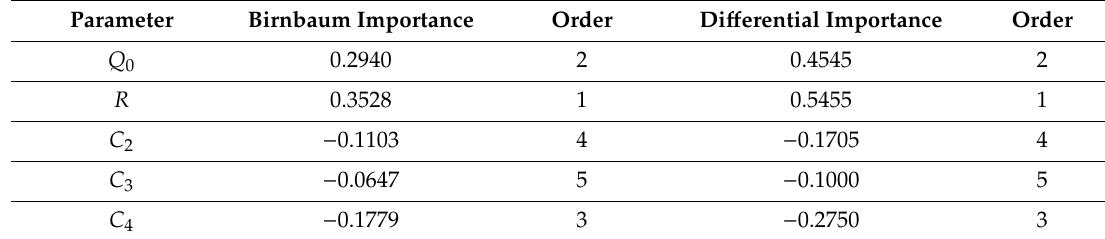
Table 5. The results of importance